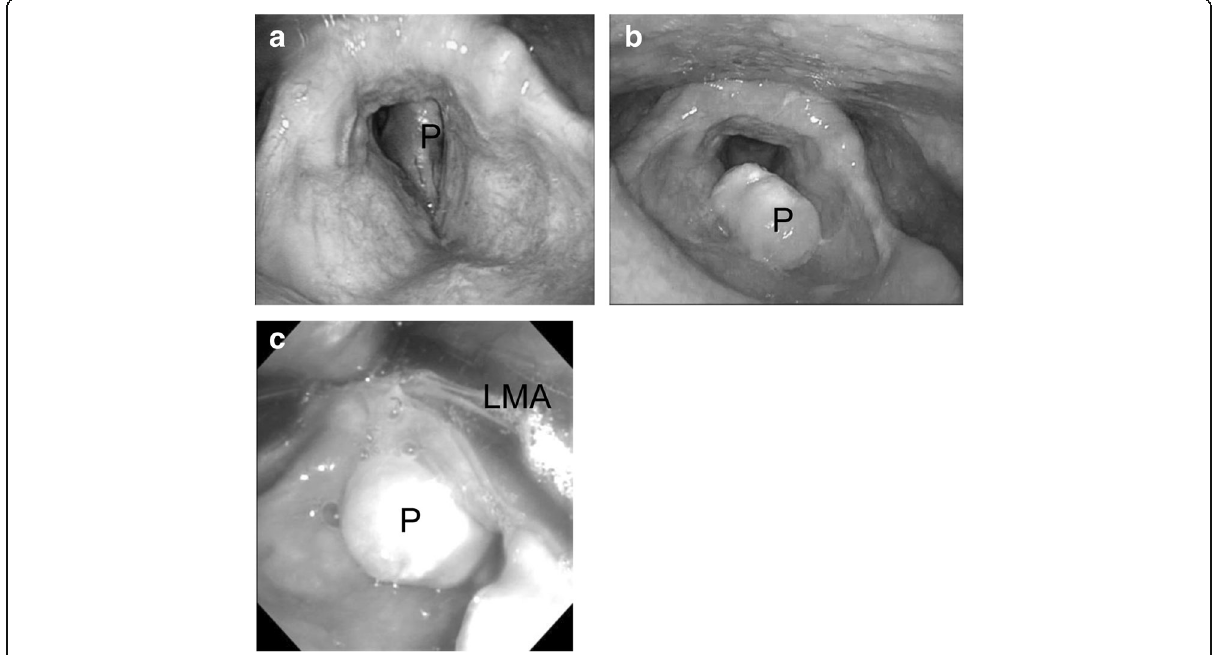
Fig. 1 Laryngoscopic images of the glottis in a patient with a large laryngeal polyp. Preoperative laryngoscopic images of the glottis show the large laryngeal polyp attached to the right vocal fold that synchronously swung inward into the trachea and outward to the larynx with inspiration ( a ) and expiration ( b ), respectively. An intraoperative image shows that the polyp was located between the vocal cords and immovable after LMA insertion ( c ). P laryngeal polyp, LMA laryngeal mask